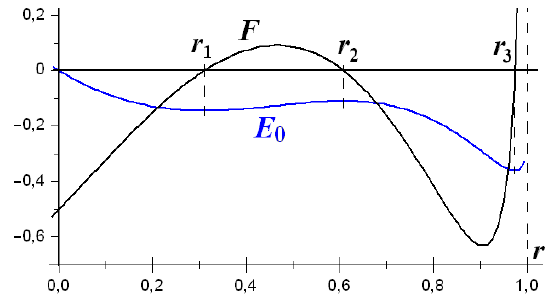
Figure 2. y = F ( r ) (black curve) and y = E 0 ( r ) (blue curve), H = 1 .